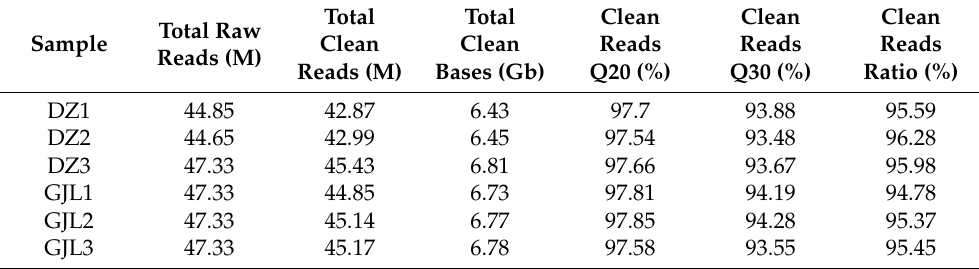
Table 1. Quality of RNA-seq data from toxicity of tritiated water